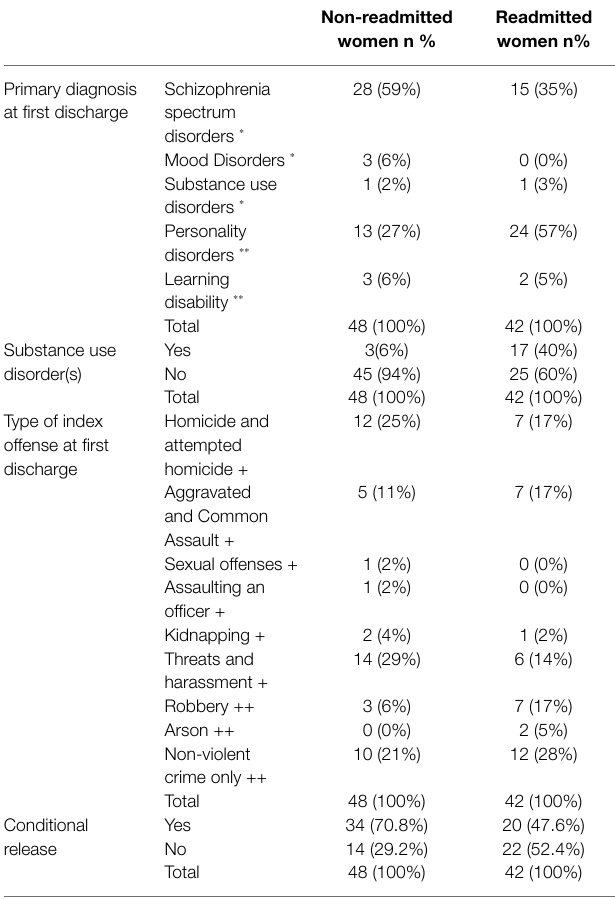
TABLE 1 | Clinical and legal characteristics of discharged